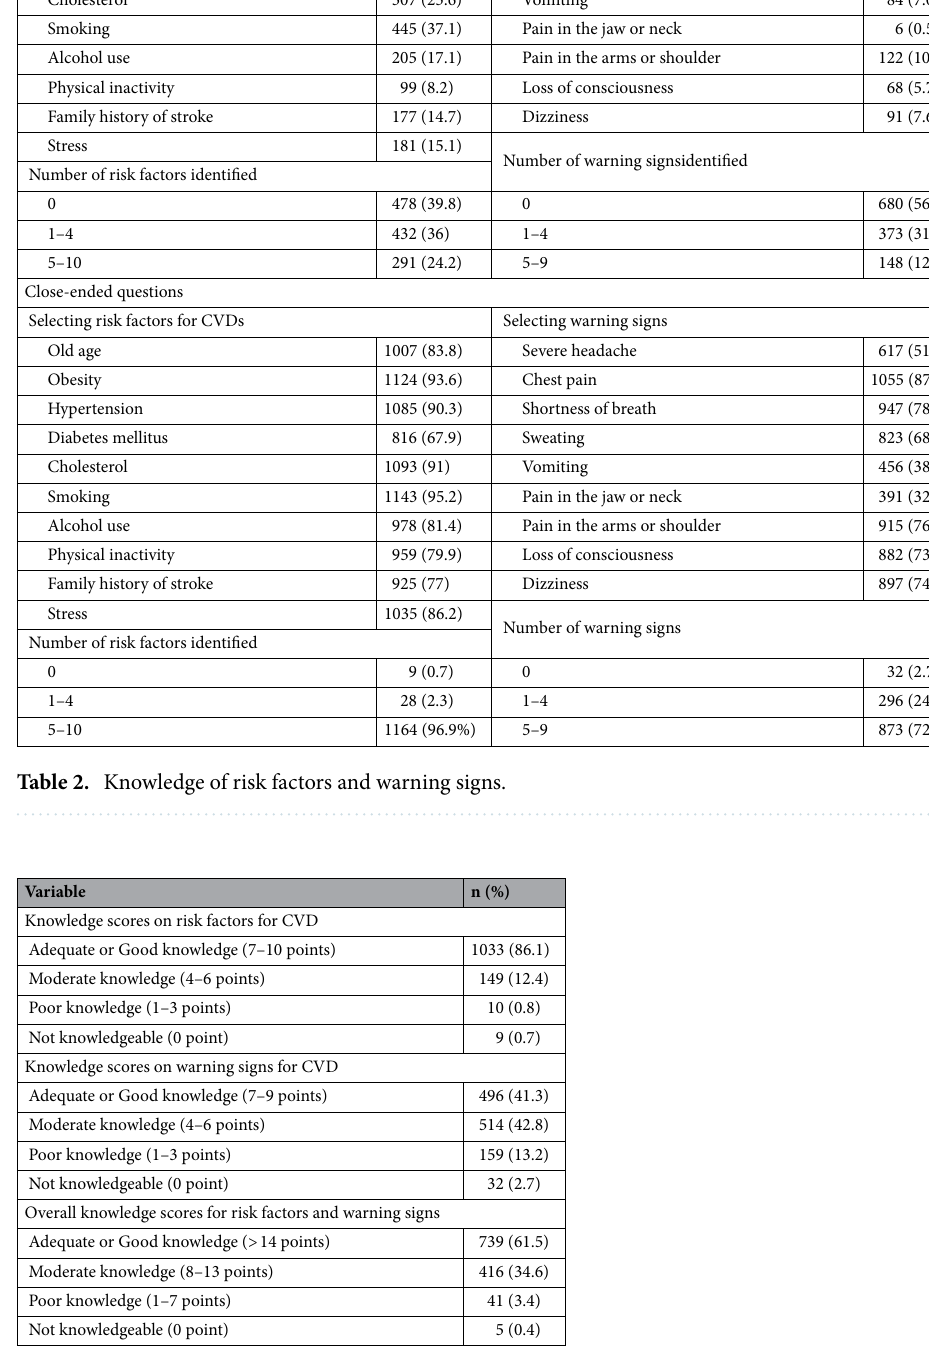
Table 3. Participants’ knowledge scores for risk factors, warning